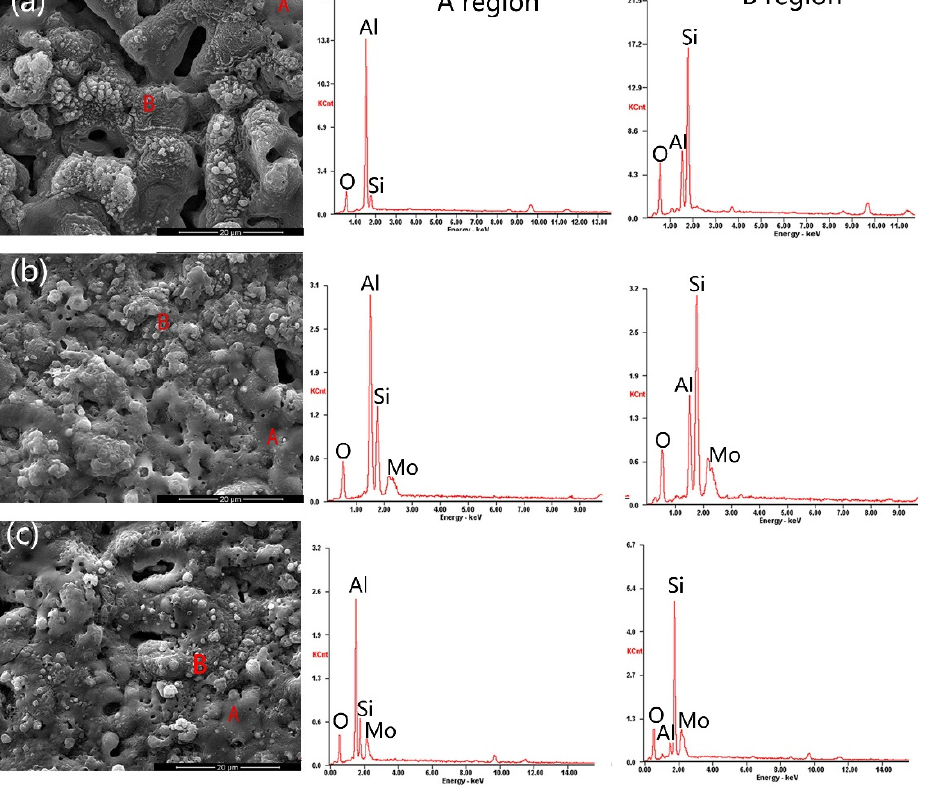
Figure 2. ( a ) Cross-section morphology of coating C, and ( b ) distribution of elements of coating C.